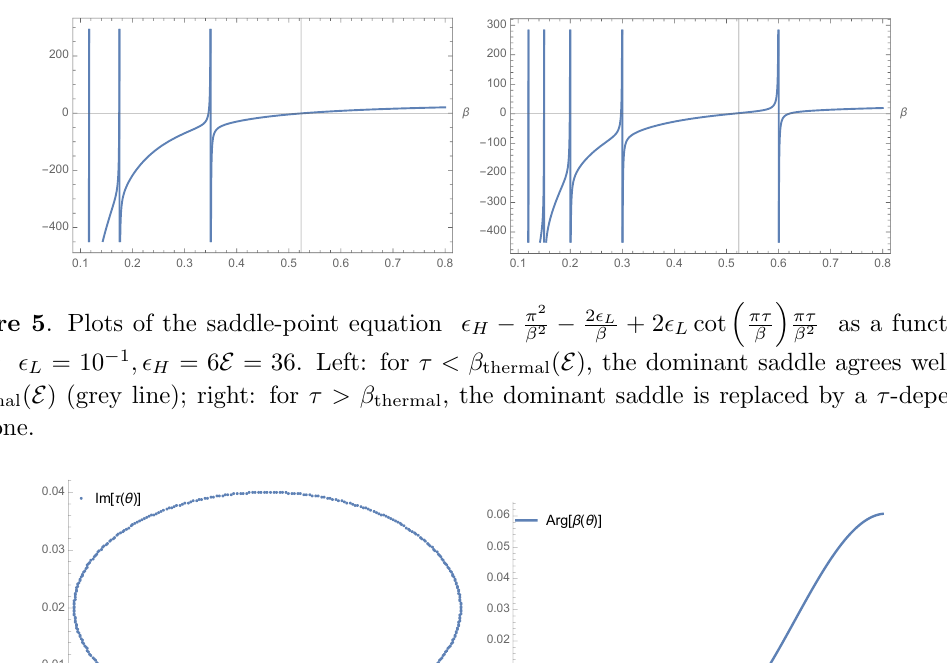
Figure 6 . Monodromy for the dominant saddle (cid:12) ( (cid:28) ( (cid:18) )) (right) as we trace a contour (left) sur- rounding the a branch point near the thermal pole (cid:28) = (cid:25) symmetric branch point exists in the lower half complex (cid:28)